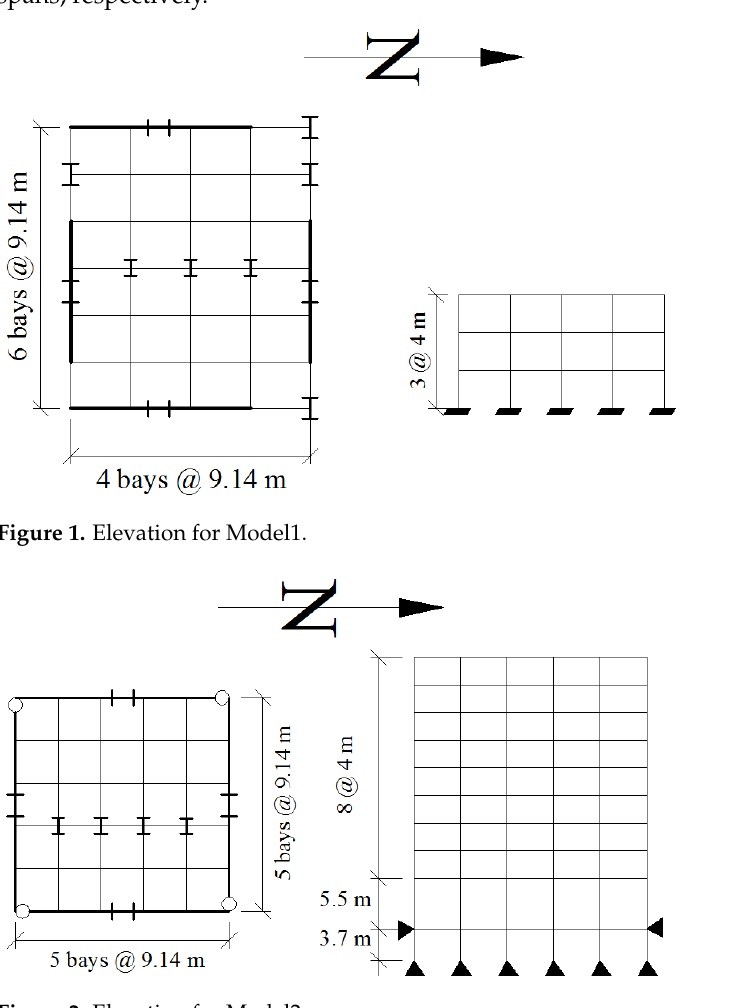
Figure 2. Elevation for Model2 .